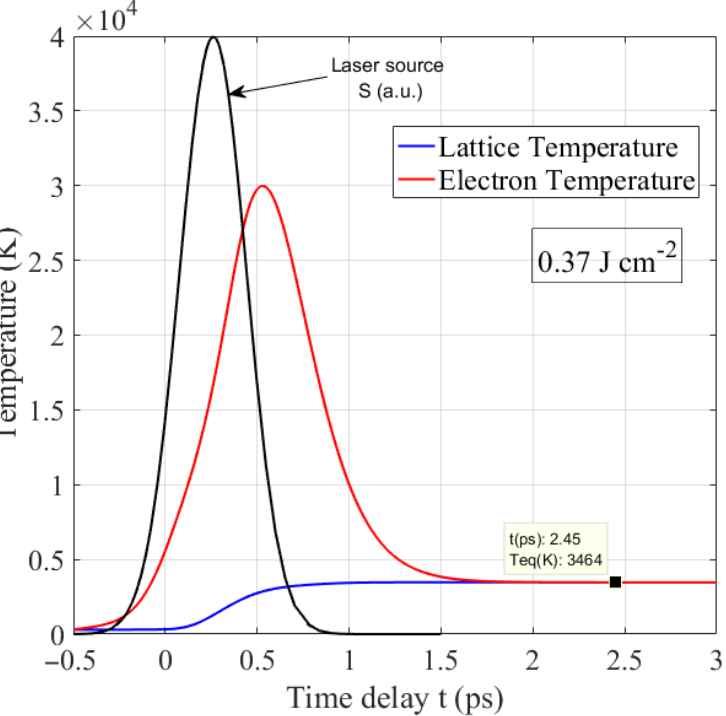
Figure 1. Electron and lattice temperature evolution as a function of time for a Ge thin film under a single 300 fs laser pulse irradiation, at 1030 nm wavelength and a fluence of 0.37 J cm −2 . The laser pulse heat profile (black line) is plotted in arbitrary units.